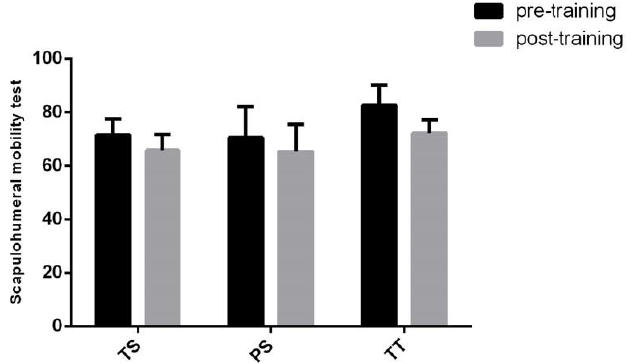
Figure 10. Flexibility of the spine. The results are represented in bar graphs as the mean ± SD of the different phases considered (Turgor Secundus, Proceritas Secunda and Turgor Tertius).